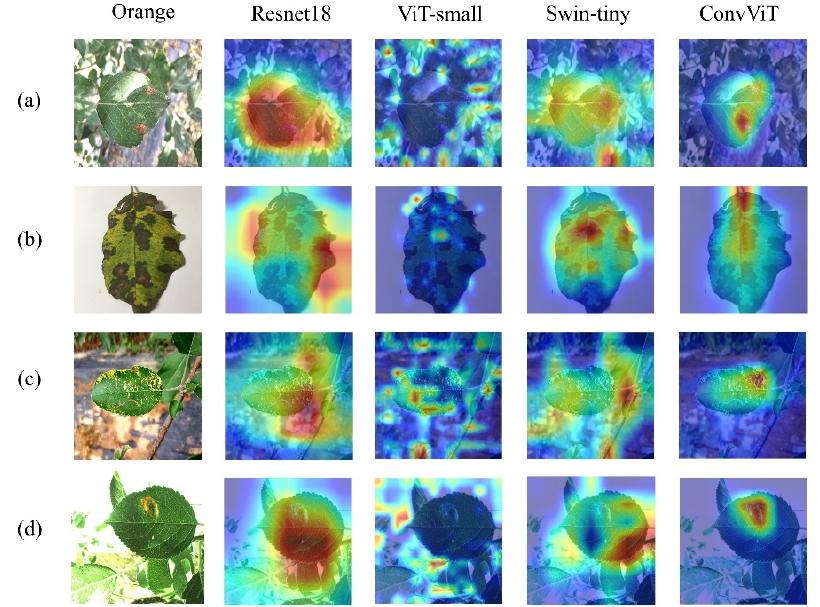
Figure 13. The visual analysis of identification results of different models on the apple disease dataset, ( a – d ) are several leaf disease samples in the dataset.